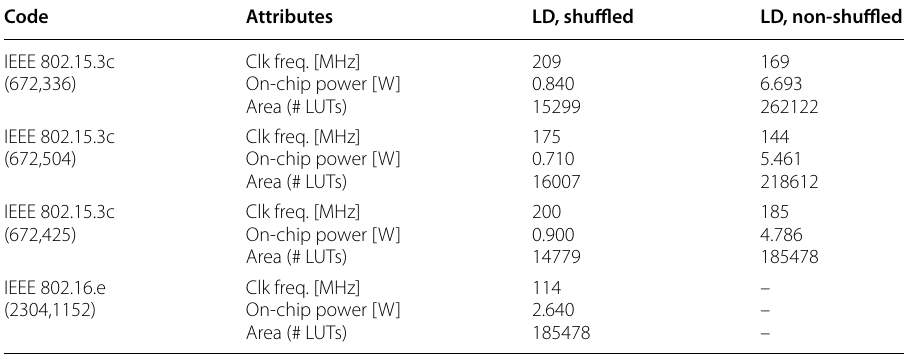
Table 1 Implementation results of the example codes on a Xilinx Virtex-7 FPGA